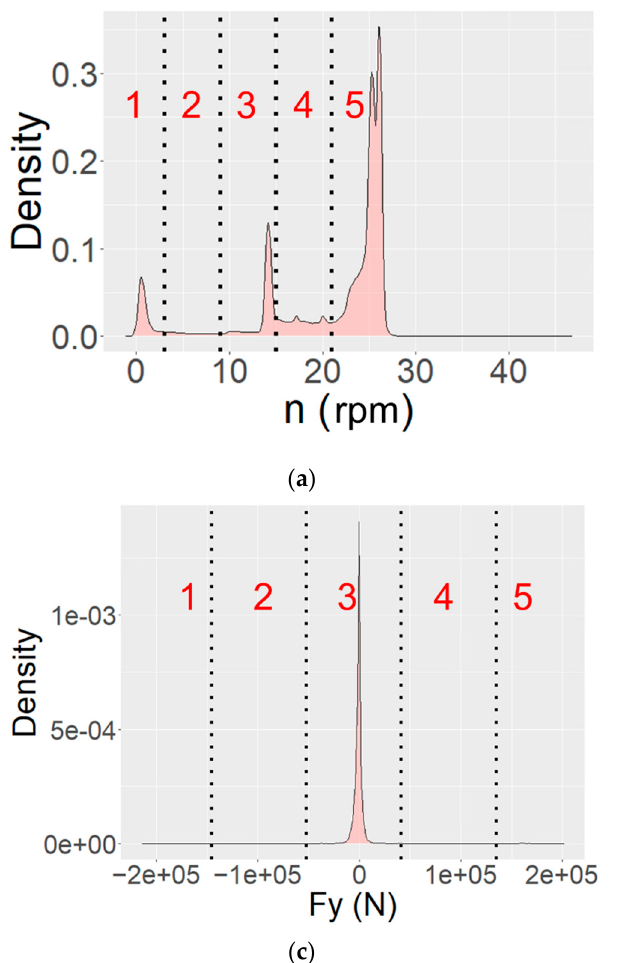
Table 7. Parameter values tested at each factor level.